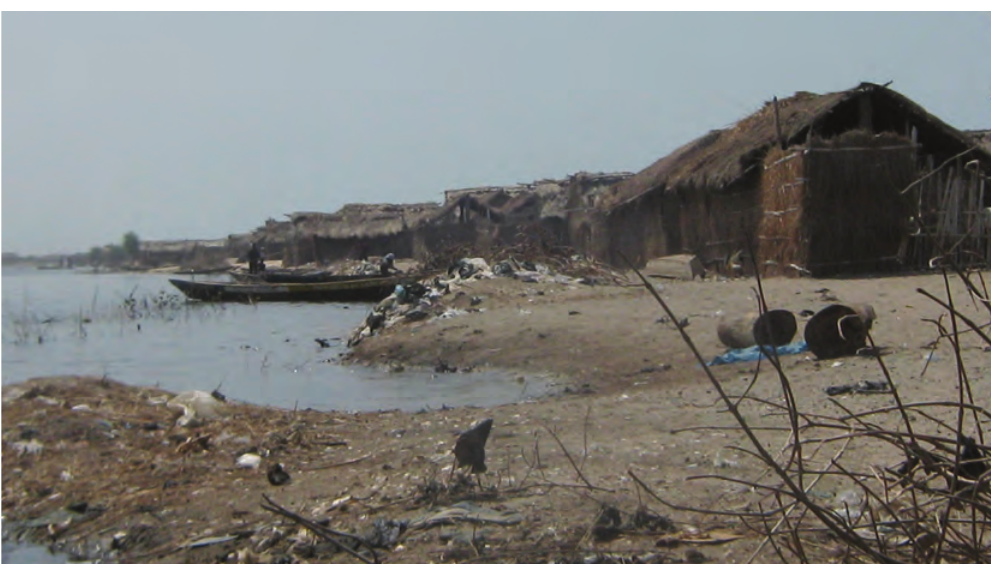
Figure 3. An overview of Faana